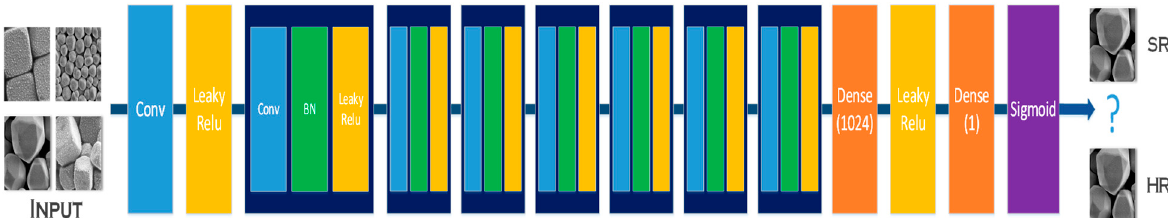
Figure 2. Architecture of our discriminator network that was used to distinguish generated SEM images from ground truth in both pixel and feature perspectives.